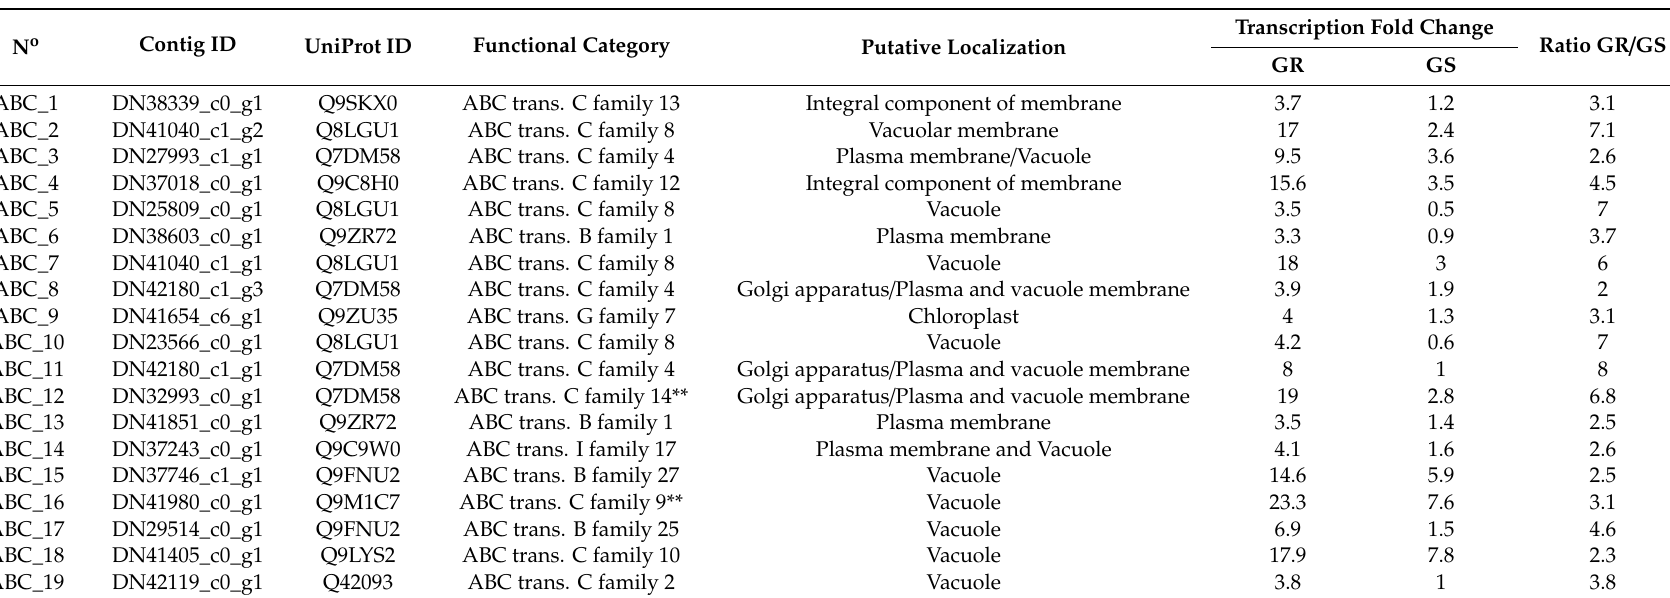
Table 1. Di ff erential expression of ABC transporter genes via RNA-Seq analysis of glyphosate-resistant (GR) and -sensitive (GS) C. bonariensis biotypes in response to glyphosate treatment up to 288 h after treatment. The transcriptional fold change data for the GR and GS biotypes are each expressed as the ratio of the ABC transporter gene expression from glyphosate treated to untreated individuals. Therefore, a value of 1 means the gene was neither induced nor repressed. The rightmost column represents the ratio of ratios; i.e., the magnitude of e ff ect of being